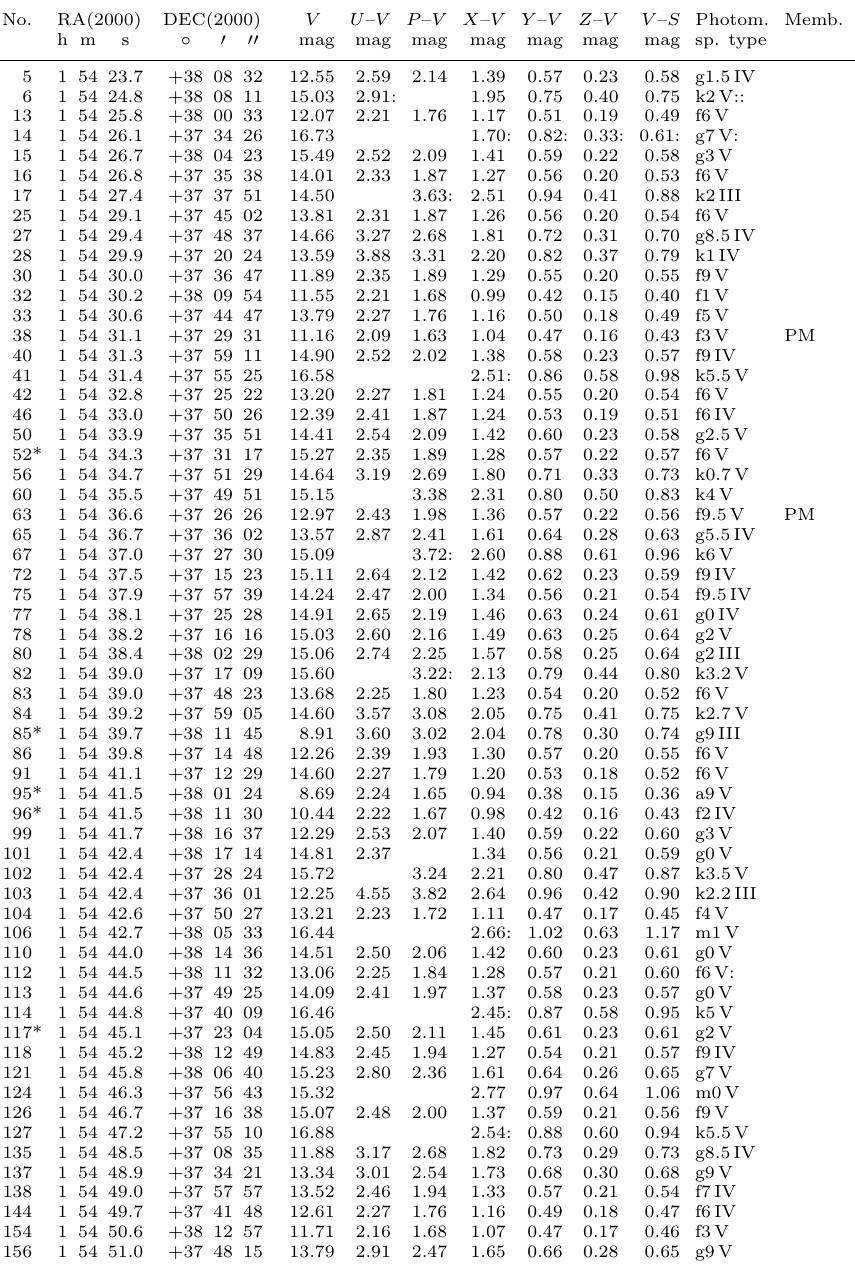
Table 3. Results of photometry and classification of stars in the NGC 752